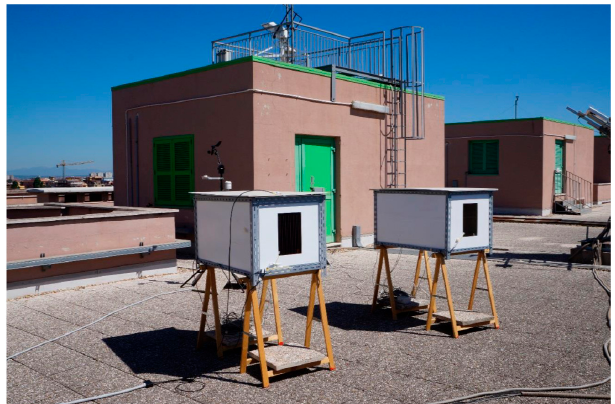
Figure 1. Solar Test Box (STB) exposed at ESTER lab for the monitoring campaign.